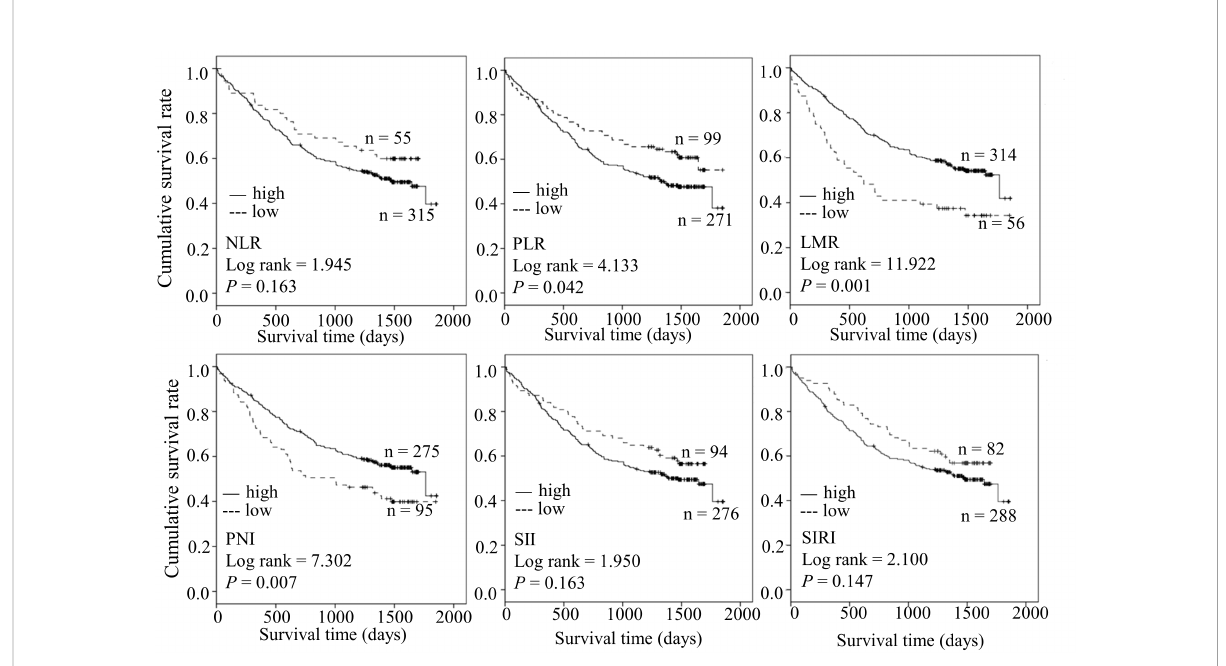
FIGURE 1 The prognosis predicting role of preoperative NLR, PLR, LMR, SII, SIRI,